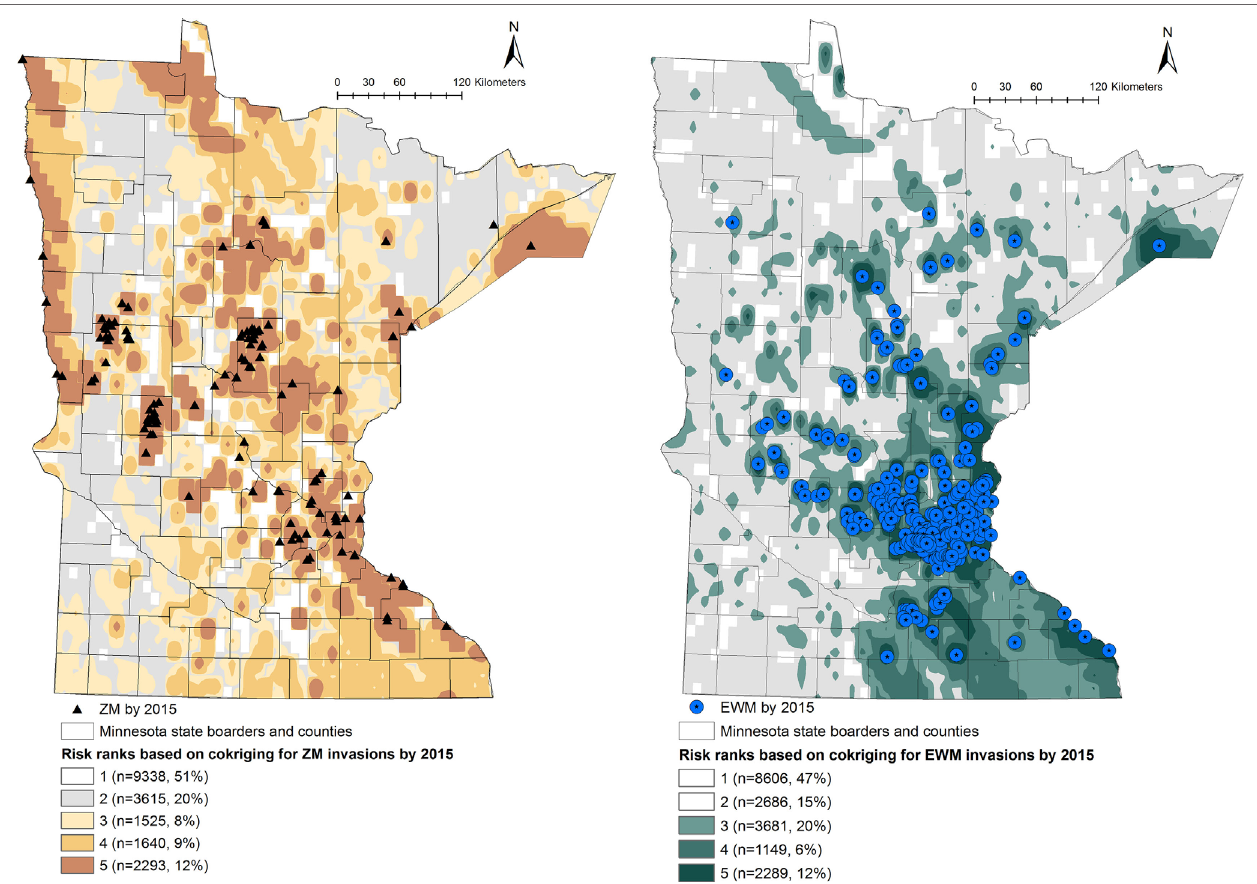
FigUre 2 | Co-kriging model outputs illustrating the probability of introduction of zebra mussels (ZMs) and Eurasian watermilfoil (EWM) to Minnesota waterbodies, for the invasion status of 2015. The risk classes 1 through 5 indicate the intensity of the probability of introduction, where class 5 represents a high probability of ZM or EWM introduction. The number of waterbodies under each category and as a percentage of the total waterbodies ( n = 18,411) is